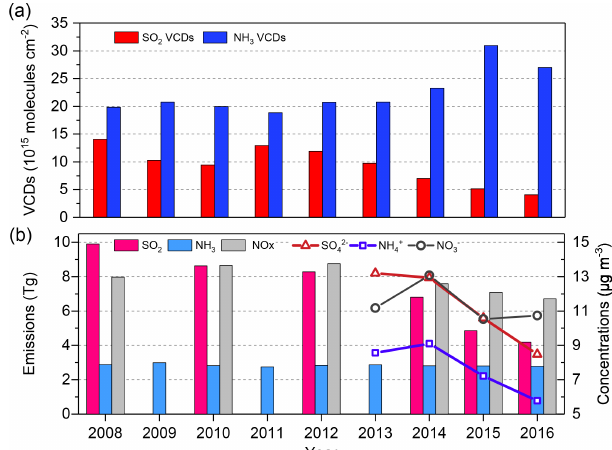
Figure 1. (a) Inter-annual trends of SO 2 and NH 3 VCDs averaged over the North China Plain from 2008 to 2016. (b) Inter-annual trends of emissions of SO 2 NH 3 , and NO x in the North China Plain from 2008 to 2016, and annual mean concentrations of PM 2 . 5 sul- fate, ammonium, and nitrate derived from measurements at an urban station (Beijing, 39.99 ◦ N, 116.3 ◦ E) in the North China Plain from 2013 to